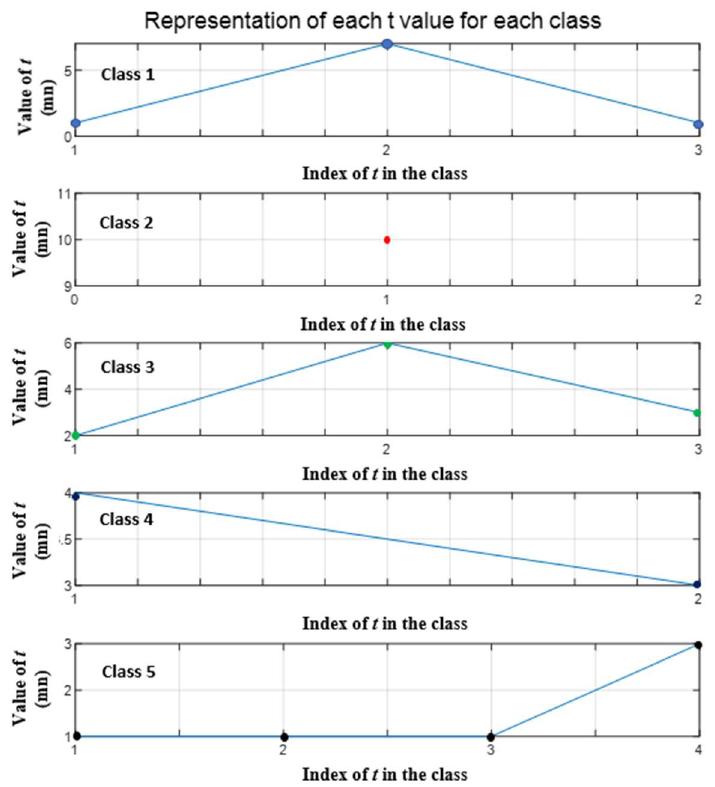
Figure 6. Representation of each value of t per class.